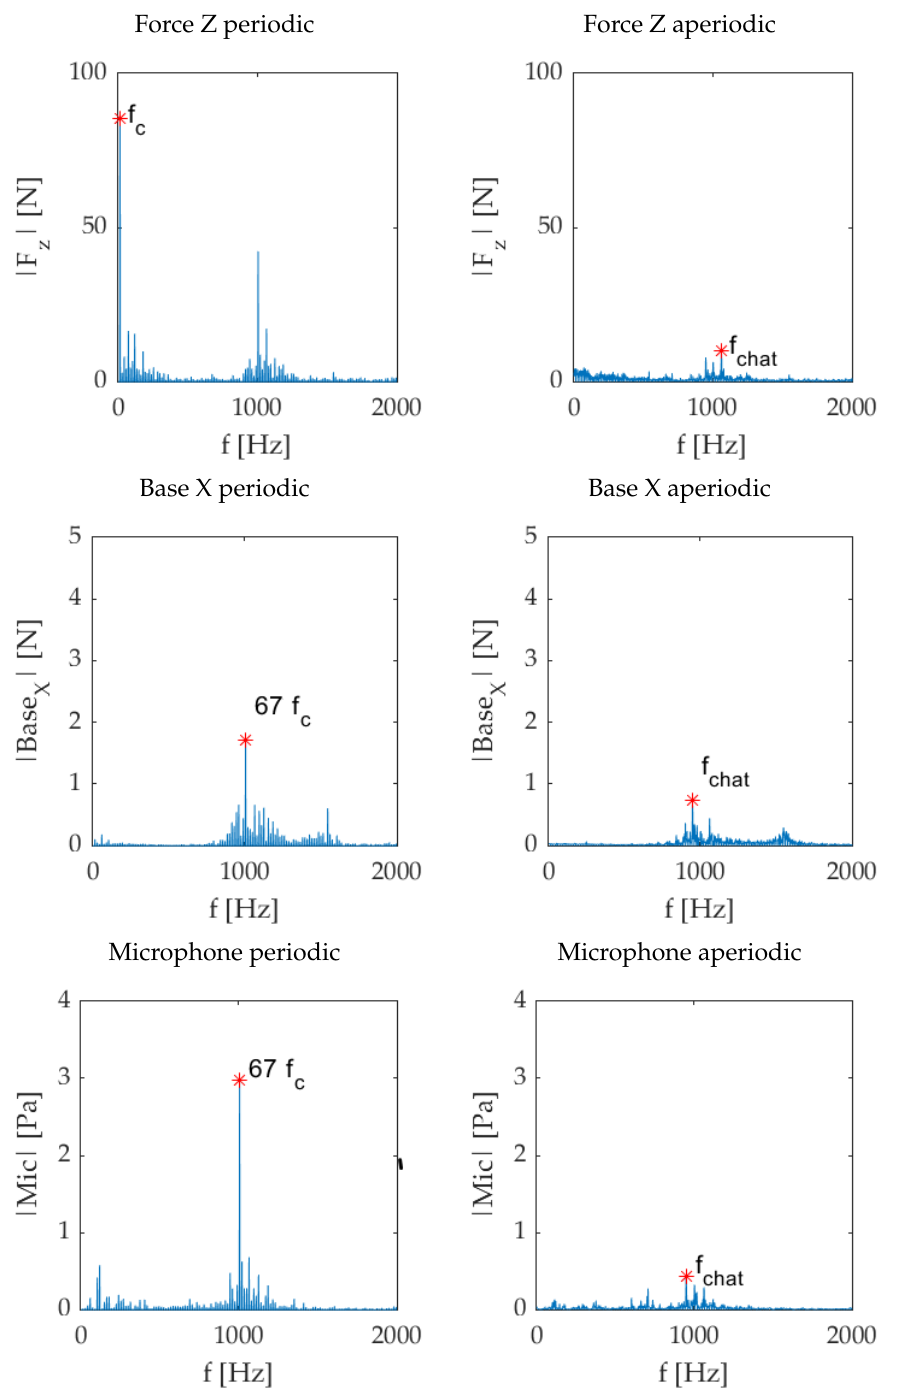
Figure 11. Signal spectra for “always stable”